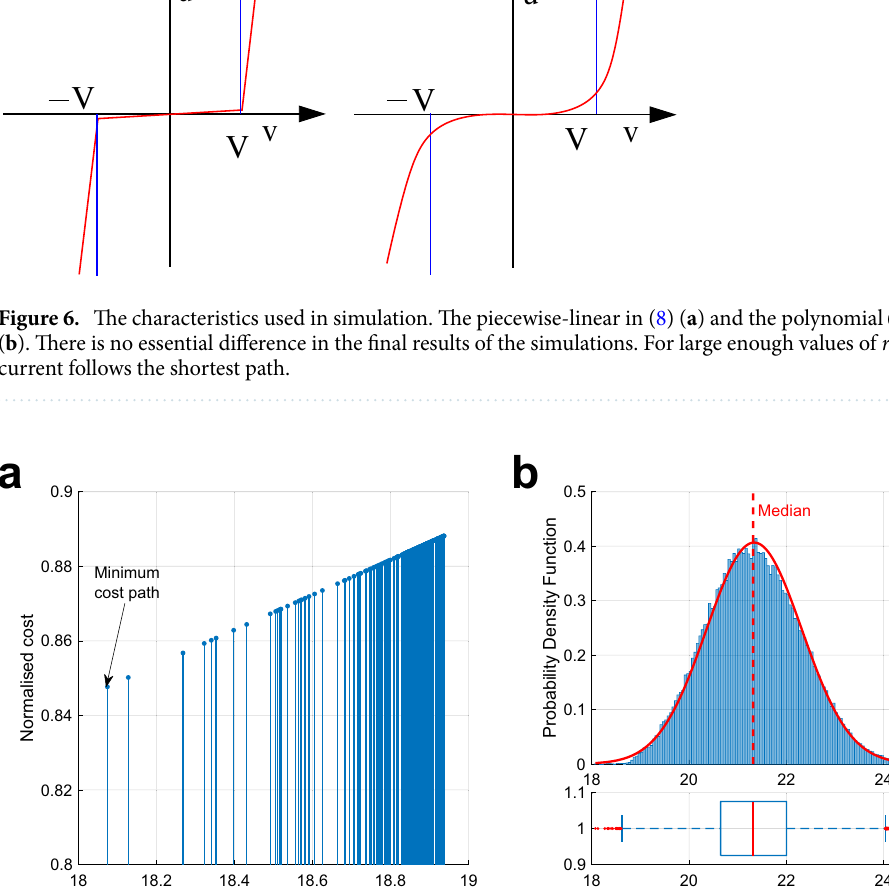
Figure 7. Cost analysis of randomly generated paths. Comparative analysis of the 200 paths with lowest cost ( a ) 5 and cost statistics of all the 10 randomly generated paths ( b